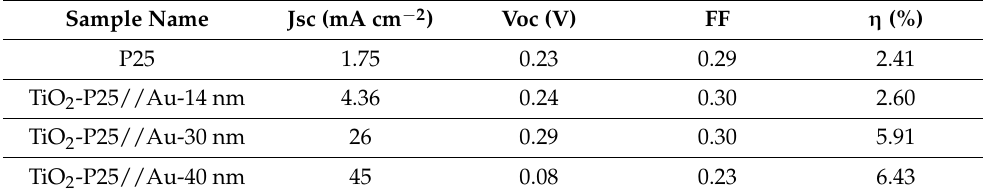
Table 1. Photovoltaic Parameters of DSSC based on Various